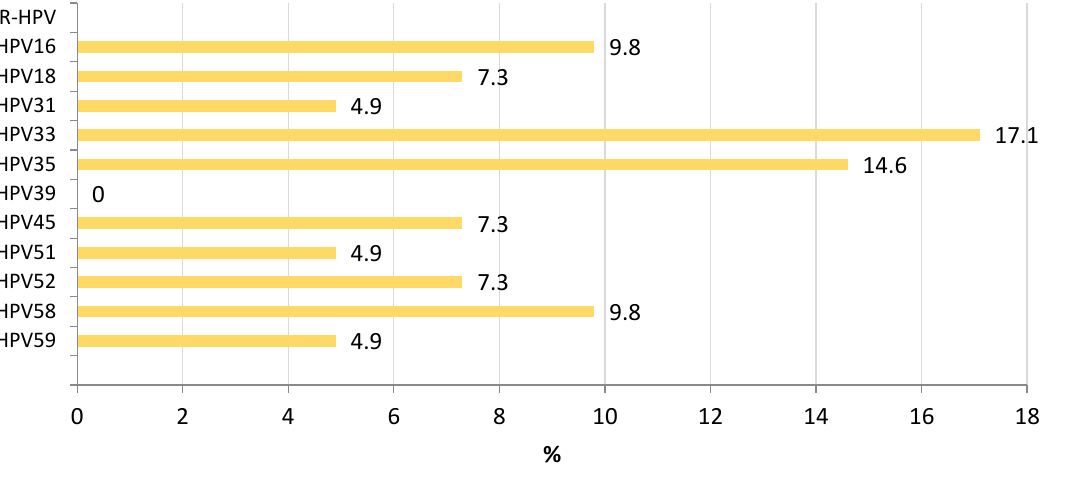
Figure 2. Prevalence of HR-HPV among participants with low-grade intraepithelial lesion (LSIL) in Kinshasa.